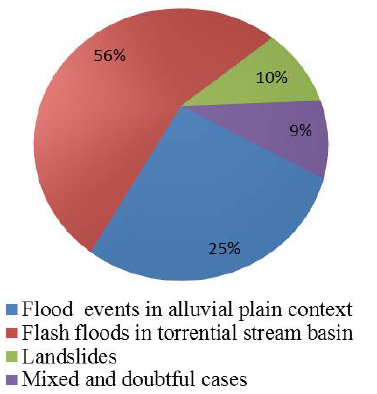
Figure 2. Event types collected while constructing the database.